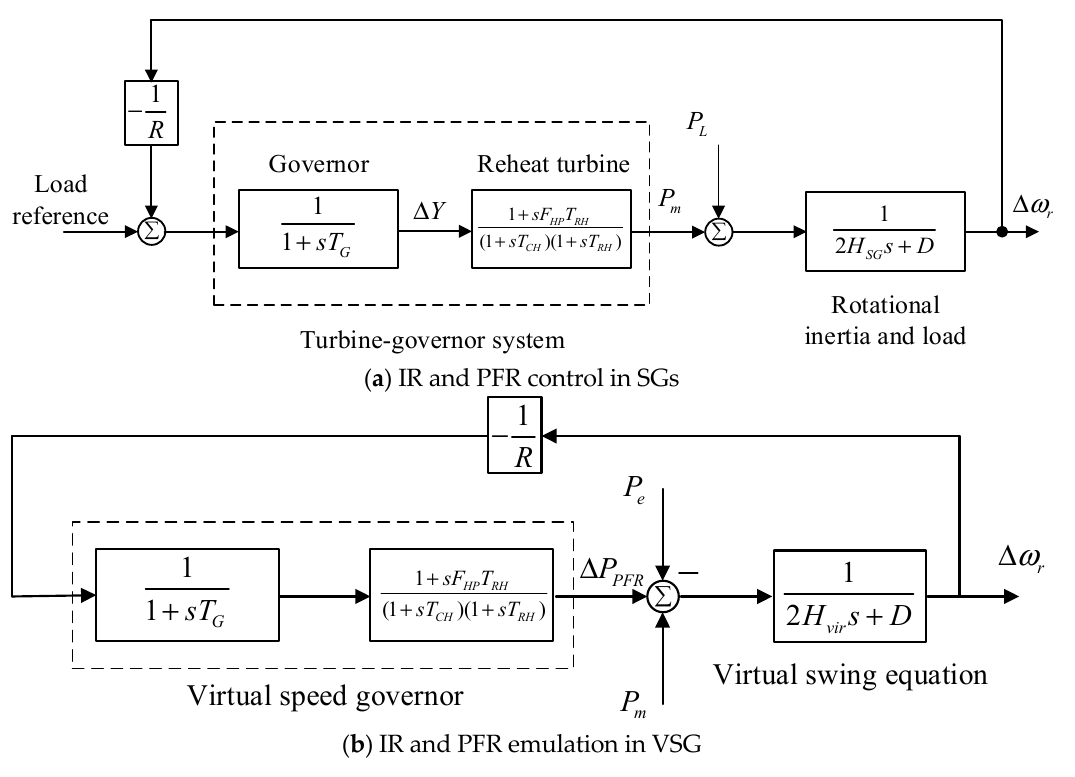
Figure 1. Block diagram of IR and PFR in ( a ) SG, ( b ) VSG.